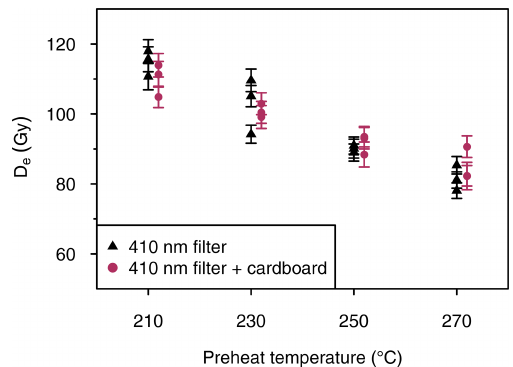
Figure 11. Dose recovery test (RIN2 F, 130Gy given dose) at dif- ferent preheat temperatures with and without a mounted cardboard barrier to reduce photon